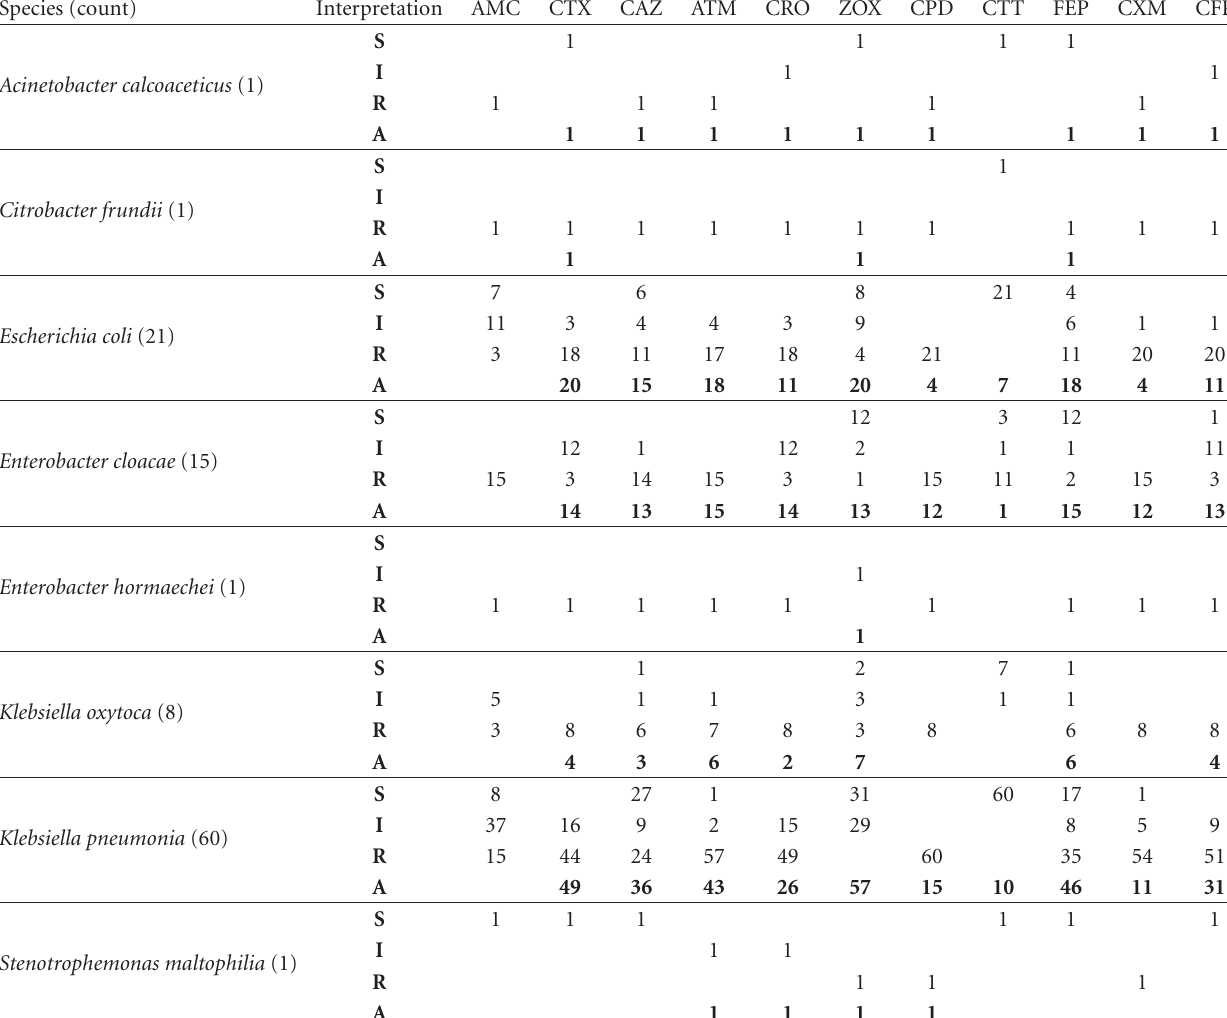
Table 3: E ffi casy of cephalosporins in detecting